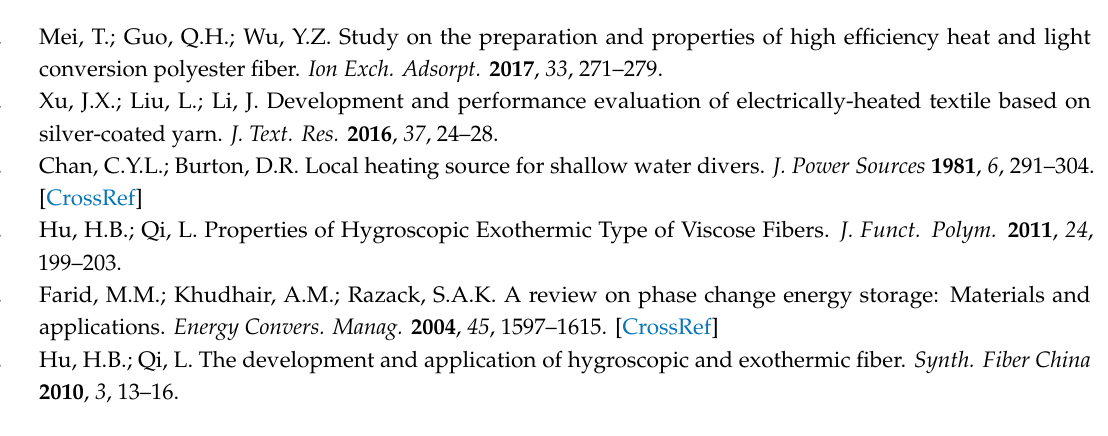
Figure S1: Temperature distribution of di ff erent fiber batting during the moisture adsorption; Figure S2: surface images and Cross section images of (a)collagen protein viscose, (b)modified PAA, (c)modified PEA, (d)modified PAN; Figure S3: TGA-DSC analysis of absorbed water state on di ff erent fibers at 20 ◦ C, 35% RH and 20 ◦ C,98% RH; Table S1: Table S1 Moisture contents of di ff erent water formations on samples at 20 ◦ C for 35% RH and 98% RH determined by TGA–DSC